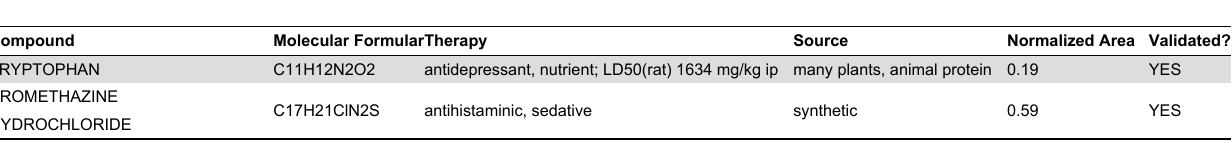
Table 4. NINDS Screen – inactive control